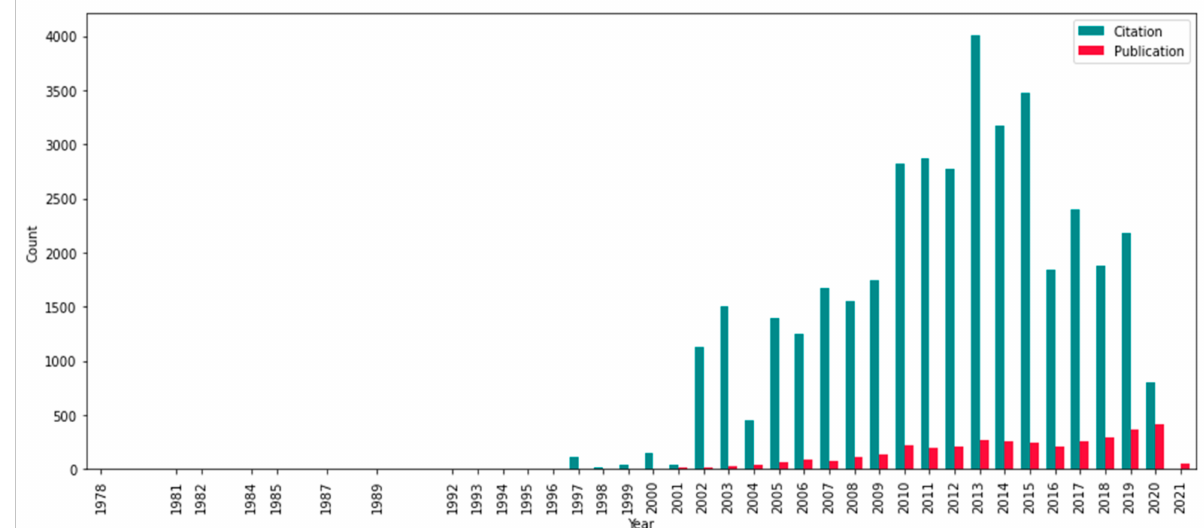
Figure 10. Number of citations and publications in each year.